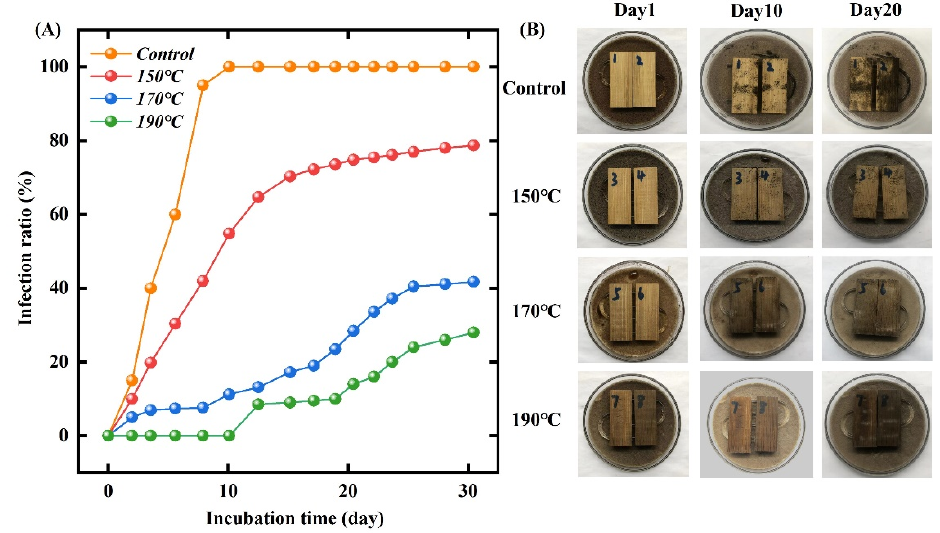
Figure 11. Anti-mildew property of different bamboo samples over 30 days: ( A ) the infection ratio of different bamboo samples in 30 days; ( B ) The picture of different bamboo samples during the anti-fungal test.